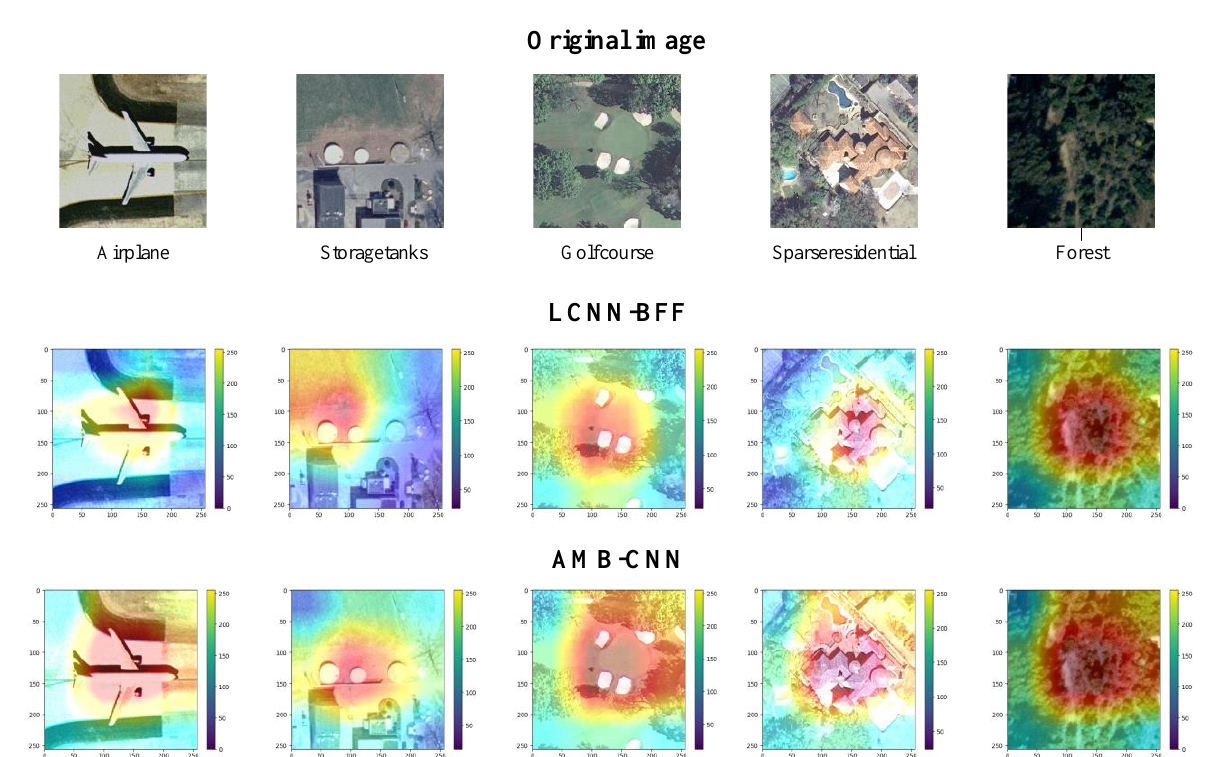
Figure 16. A thermal diagram using the UCM21 dataset.